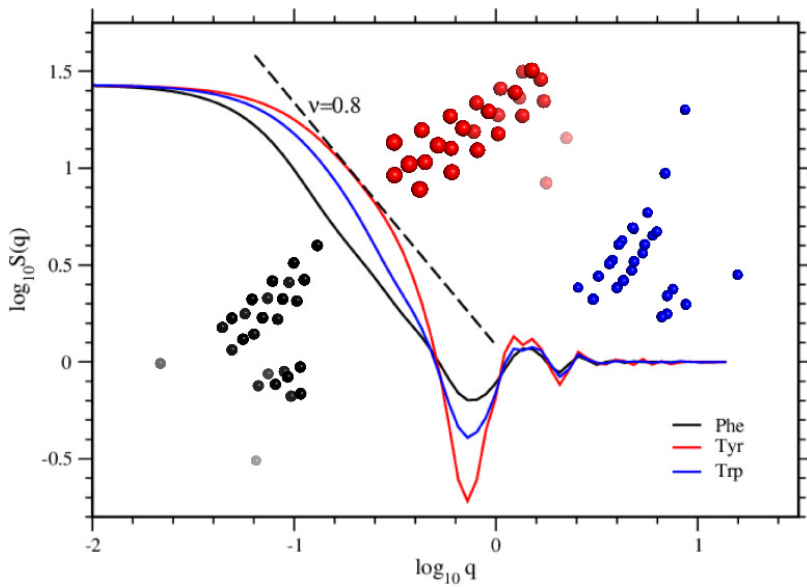
Figure 9. Structure factors are plotted for the self-assembled structures by Phe, Tyr, and Trp molecules. The snapshots of the structures are shown in the same colors as the corresponding curves. The straight dashed line shows the asymptotic scale, which is ν =